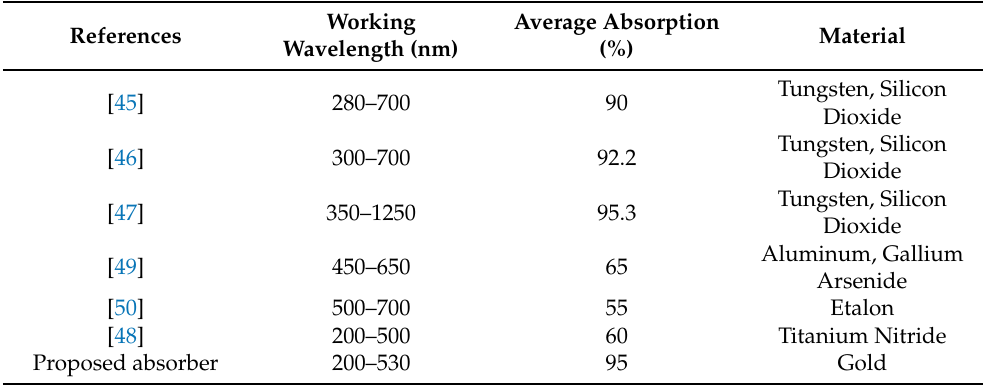
Figure 3. Normalized electrical field distribution of the absorber containing 30 × 30 cylindrical ( a ) Au and ( b ) Ag rods in air under η p = 53%, respectively. Normalized electrical field distribution of the absorber under η r = 80% containing cylindrical ( c ) Au and ( d ) Ag rods in air, respectively. The electrical field distribution are recorded at λ = λ B ; TE polarized plane waves are located at the bottom of the structure and propagate from − y to y directions and recorded at the top of the structures. Table 1. The comparison of the present work and some recent